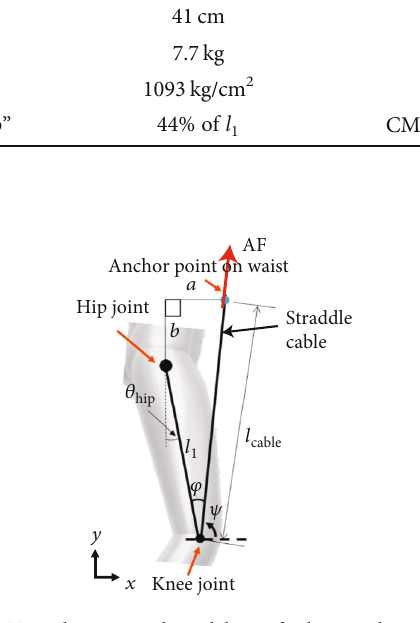
Figure 5: Two-dimensional modeling of a human leg wearing the soft exoskeleton in which the assistive forces were applied at the knee joint by pulling the straddle cable. AF: assistive forces.